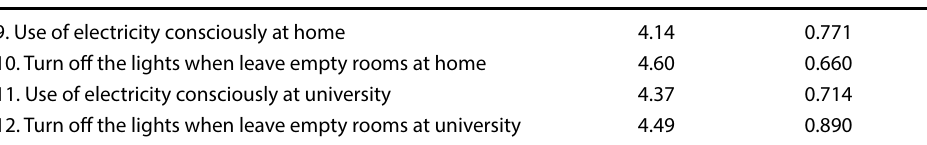
Table 2 Descriptive statistics for questions on behaviour